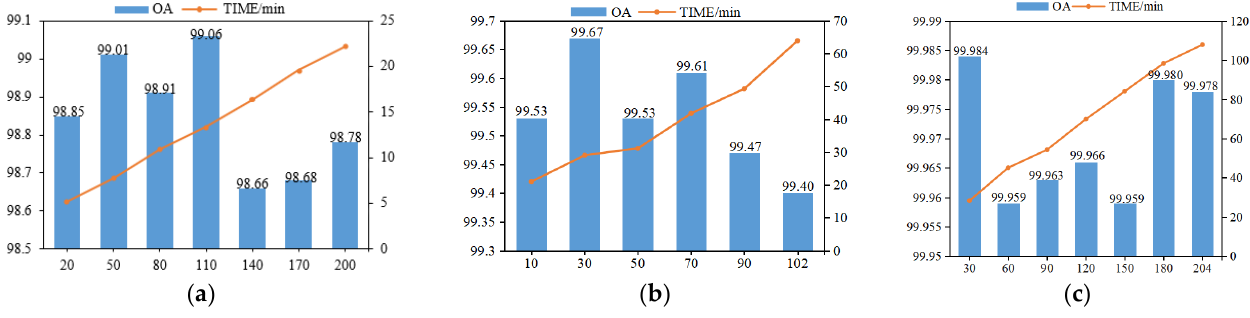
Figure 7. Comparison plots of OA and runtime when using different numbers of spectral bands on different datasets: ( a ) IP dataset; ( b ) UP dataset; ( c ) SA dataset. different datasets: ( a ) IP dataset; ( b ) UP dataset; ( c ) SA dataset. 4.